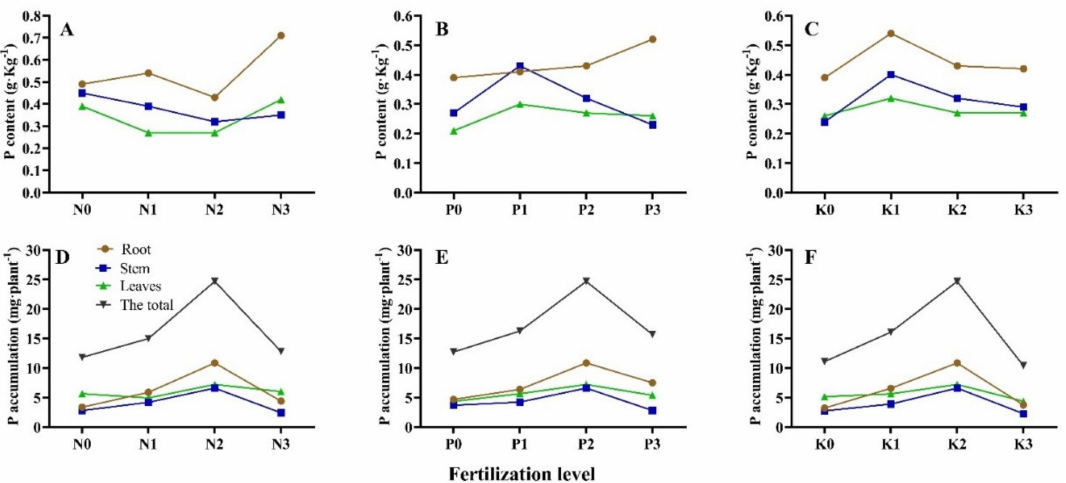
Figure 4. Changes of P content and accumulation in P. bournei seedlings under the single-factor of N, P, and K fertilizer. ( A , D ): the single-factor of N fertilizer; ( B , E ): the single-factor of P fertilizer; ( C , F ): the single-factor of K